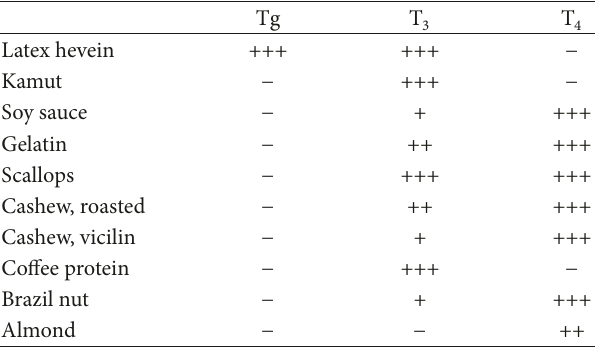
Table 3: Example of 10 selected foods and their degrees of reactivity with monoclonal antibodies against Tg, T3 and